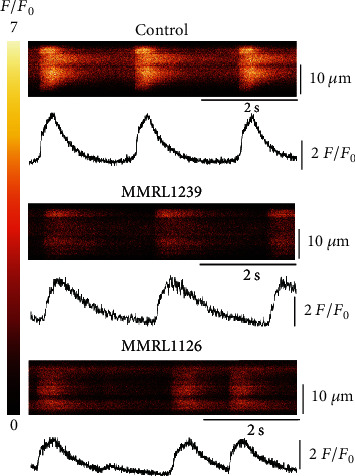
Line scans recorded from WT, MMRL 1239, and MMRL1126 hiPSC-CMs showing spontaneous Ca2+ transients in all hiPSC-CMs. However, fluorescence intensity was much lower in MMRL 1126, and spontaneous activity was episodic in nature.